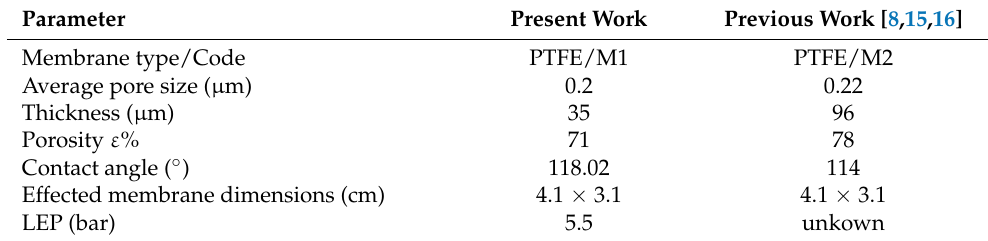
Table 1. Characteristics of the commercial PTFE flat-sheet